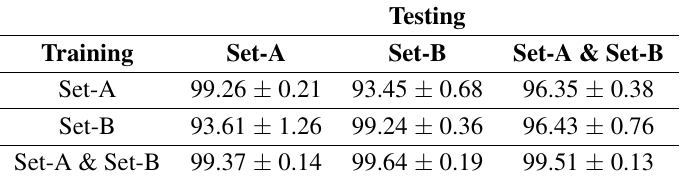
Table 1. Recognition Accuracy (Mean (cid:6) SEM) with Different Combinations of Training and Testing Data (%).